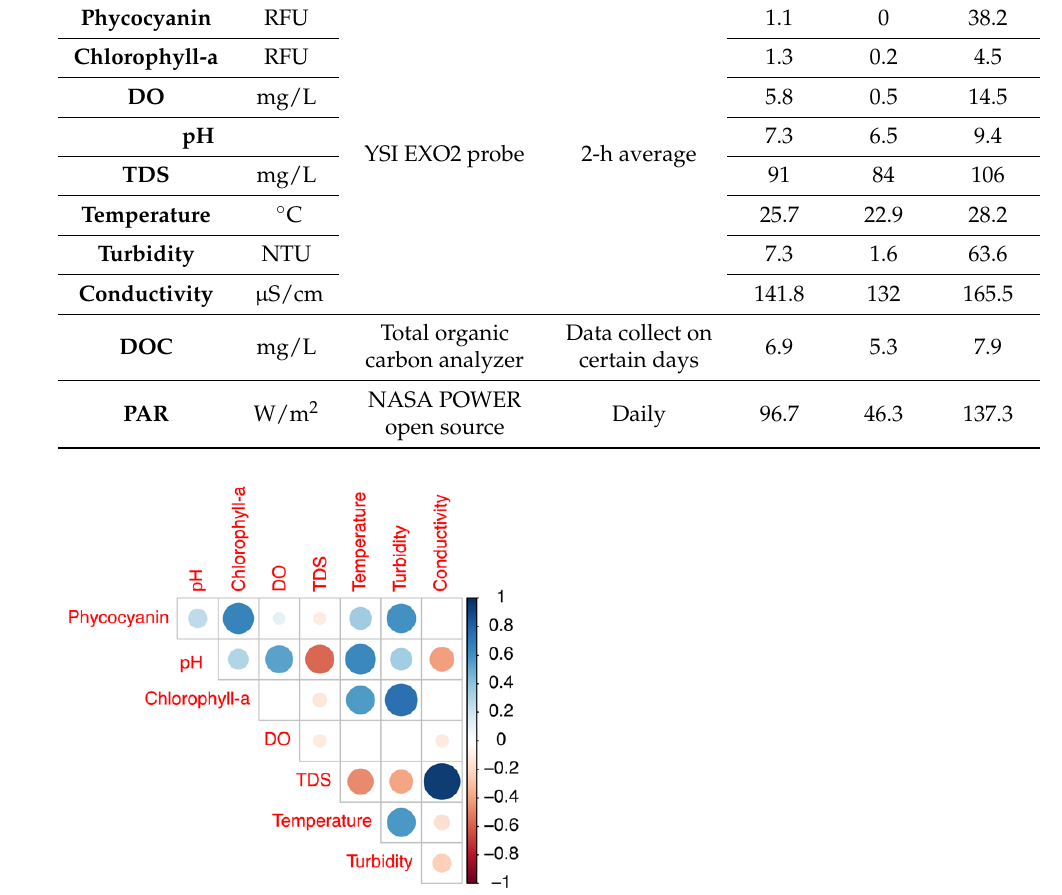
Figure 7. Correlation plot of physicochemical variables for the raw water of Bedford drinking water treatment plant (DWTP) during July and August of 2018.